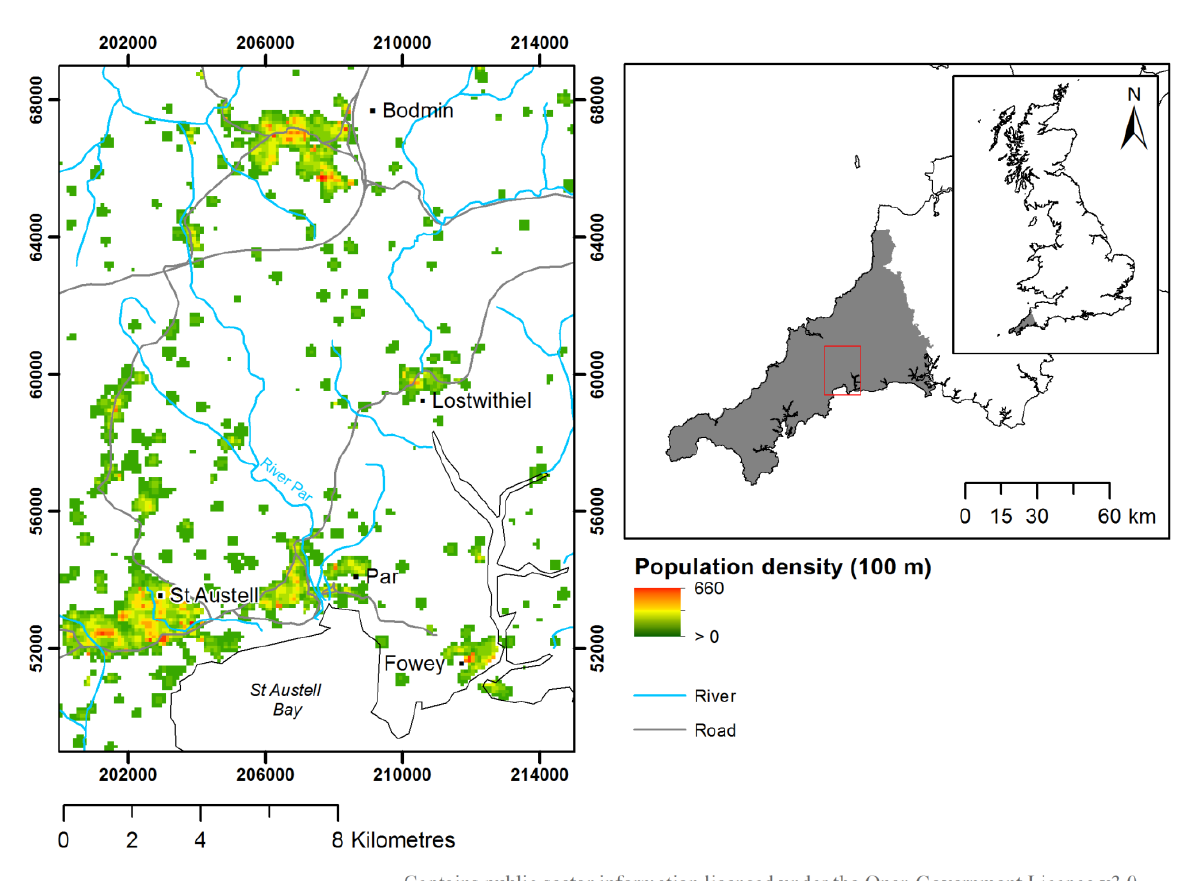
Figure 1. St Austell study area outlined in red, showing location within Cornwall (shaded grey) and Great Britain insets. An example 100 m gridded population distribution provided for contextual